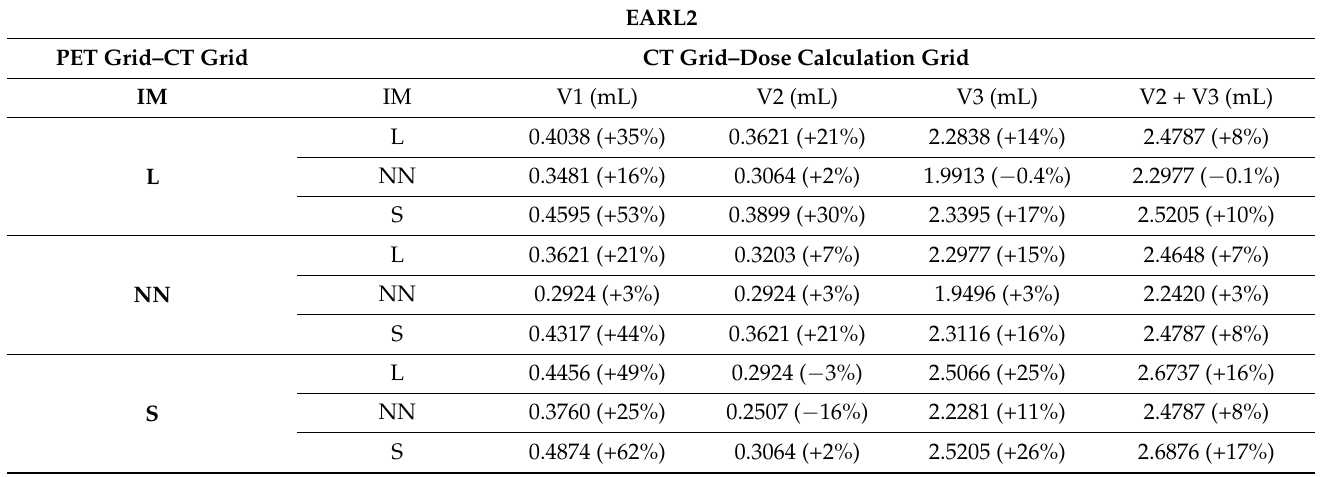
Table 2. Obtained volumes with each interpolation method for EARL2 reconstruction. The deviation from the actual volume is shown in